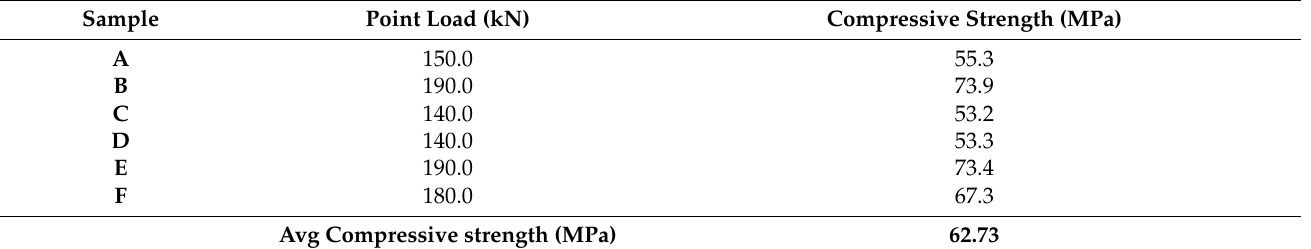
Table 4. Results of tests of the uniaxial compressive strength (top), flexural strength (centercnter) and micro-Deval wear resistance (bottom) carried out on specimens derived from CFM